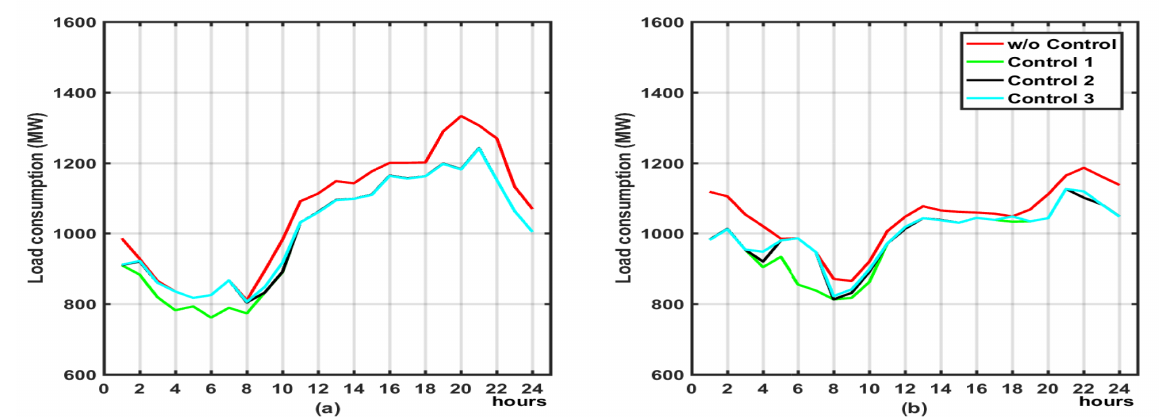
Figure 9. Load consumptions in: ( a ) Case 1 and ( b ) Case 2.